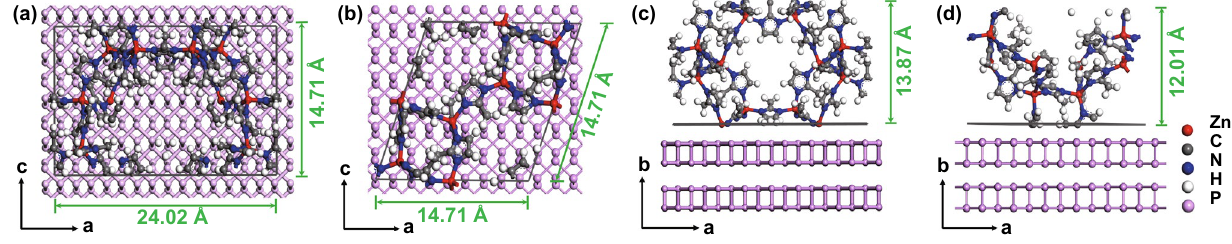
Fig. 3 Atomic arrangement of the (011) and (112) planes of a single MOF unit cell. a and b show top views of the (112) and (011) plane. c and d show side views of the (112) and (011)